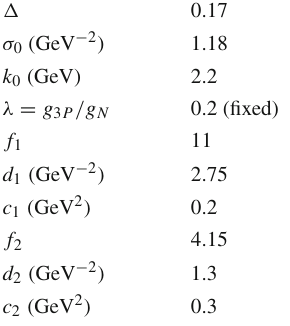
Table 1 The values of the parameters in the two-channel eikonal fit to elastic pp ( p ¯ p ) scattering